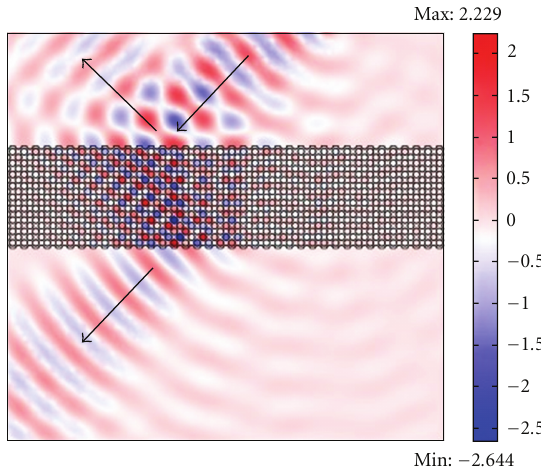
Figure 3: The negative refraction phenomena of PhC.